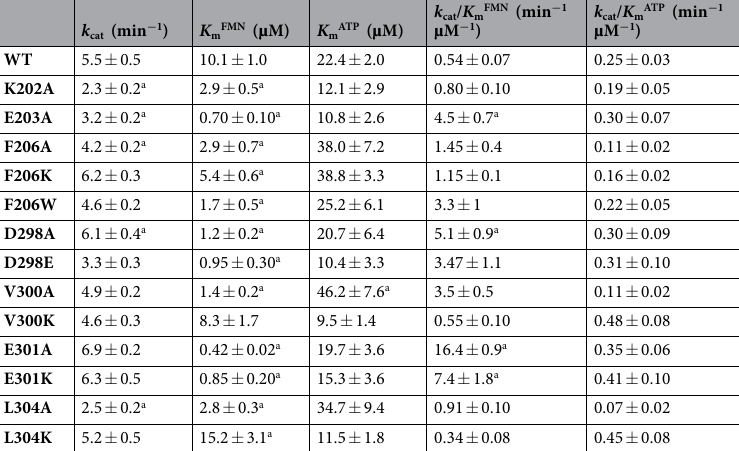
Table 2. Steady-state kinetic parameters for the FMNAT activity (FMN → FAD) of the different Ca FADS variants (n = 3; means ± SE). Data obtained at 25 °C in 20 mM PIPES pH 7.0, 10 mM MgCl 2 . a Values showing statistically significant differences from the WT, as determined by the one-way ANOVA test ( P < 0.002; n = 3, confidence interval